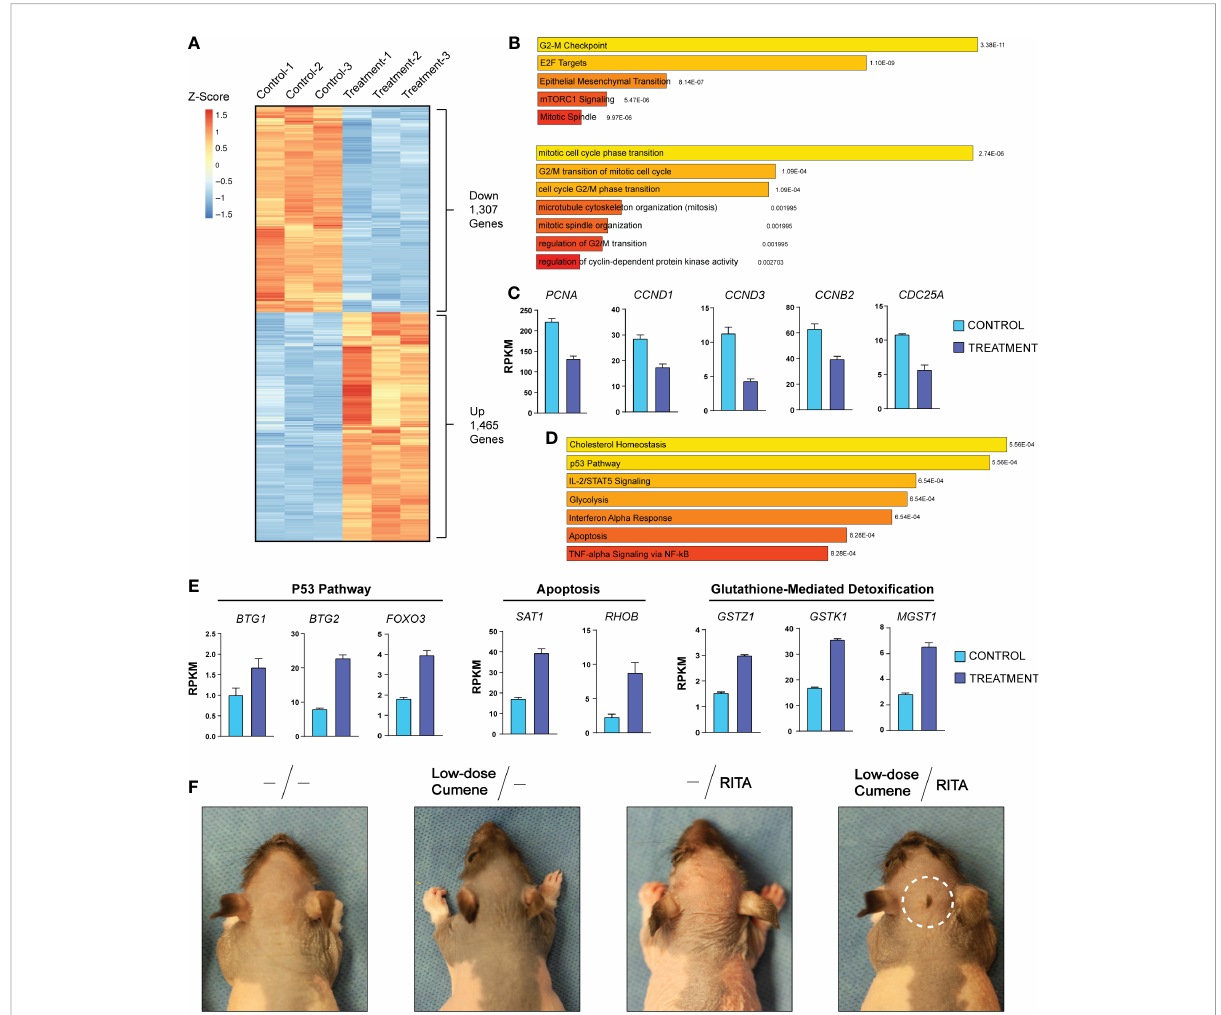
FIGURE 2 Cumene Hydroperoxide Protects Against Chemotherapy-Induced Alopecia by Activating the P53 Pathway to Arrest Cell Cycle. (A) RNA-seq heat maps of all differentially expressed genes in control and cumene hydroperoxide-treated rat skin. 1,307 genes and 1,406 genes were found to be signi fi cantly down- and upregulated, respectively. Fold change > 1.5, FDR < 0.05, N=3. (B) MSigDB Hallmark (Molecular Signature Database Hallmark) gene enrichment analysis and Gene Ontology of Biological Processes (bottom) of genes downregulated upon cumene